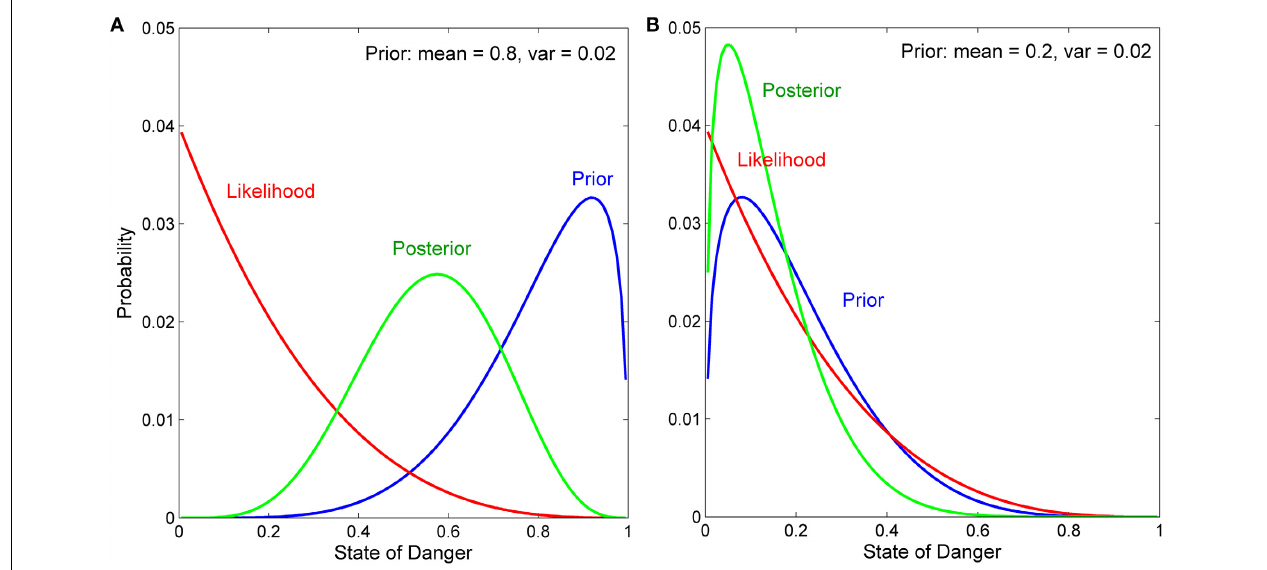
FIGURE A1 | Effect of the mean of the prior distribution on Bayesian updating. Two individuals (A,B) are both exposed to the same experience, with the likelihood function indicated in red. The first individual (A) has a prior distribution with a high mean; the second individual (B) has a prior distribution with a low mean. When the